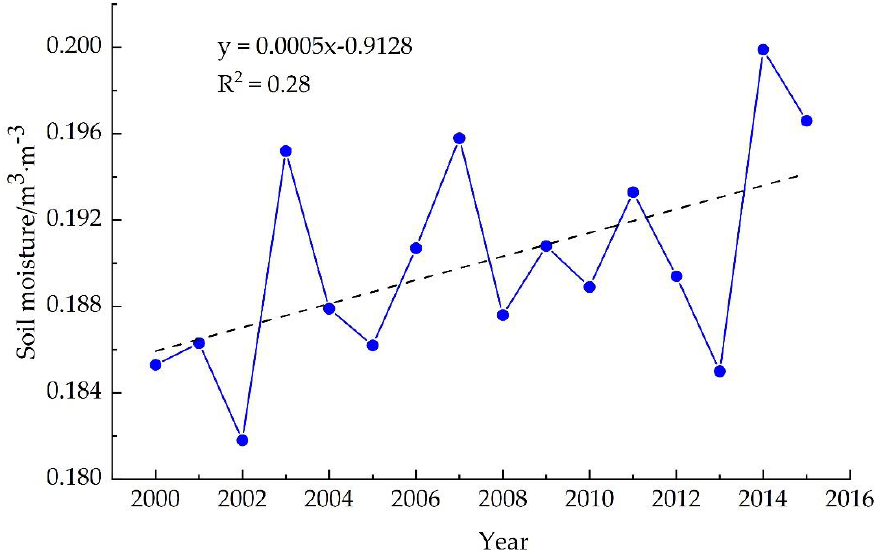
Figure 4. Interannual variation of SM in the YRB from 2000 to 2015.